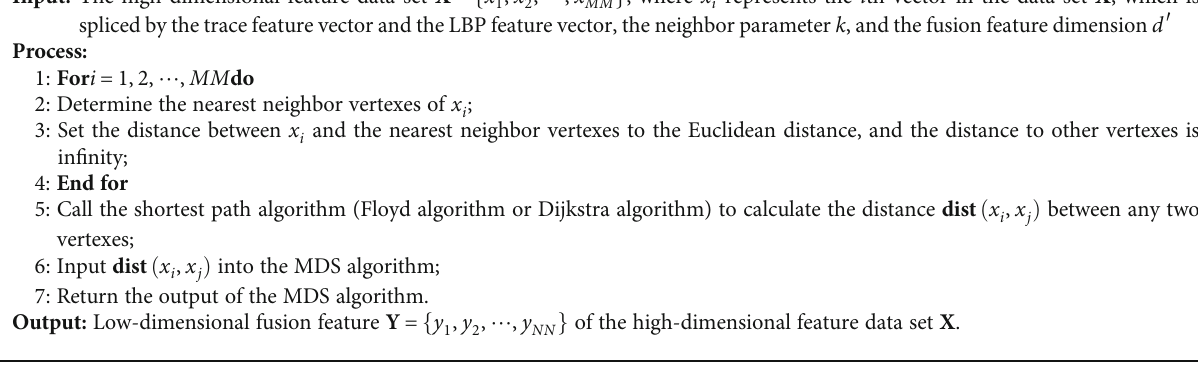
Algorithm 1. Isometric feature mapping